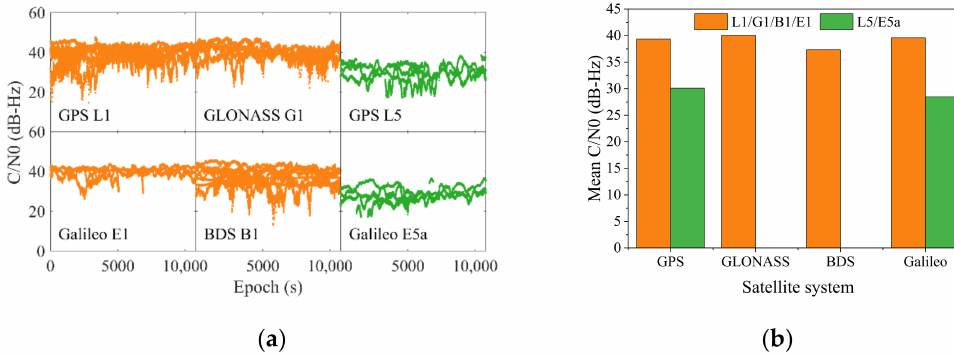
Figure 3. C/N0 of different types of observations. ( a ) C/N0 sequence. ( b ) Statistical results of mean C/N0.